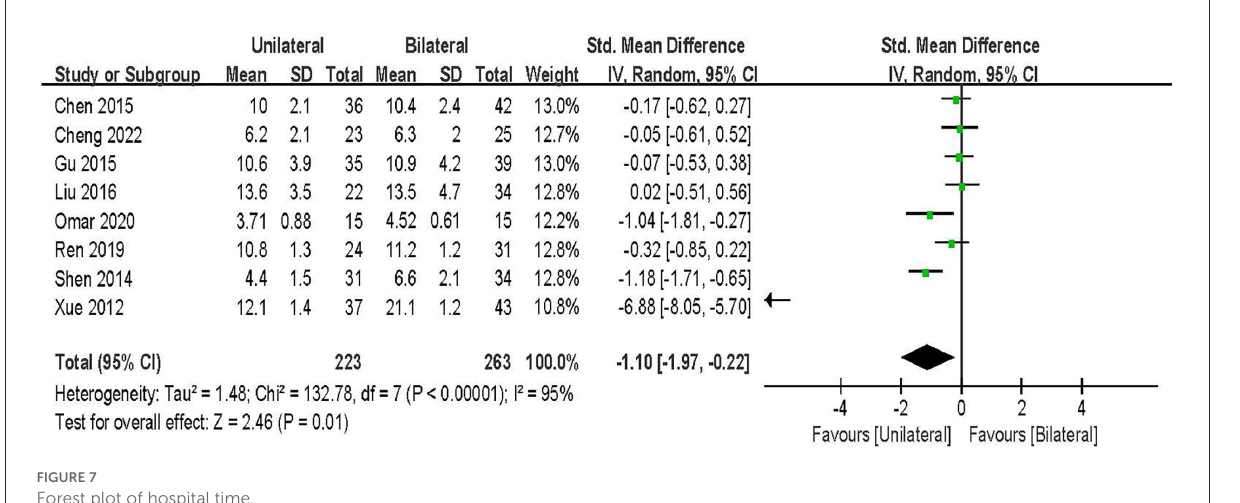
FIGURE7 Forest plot of hospital